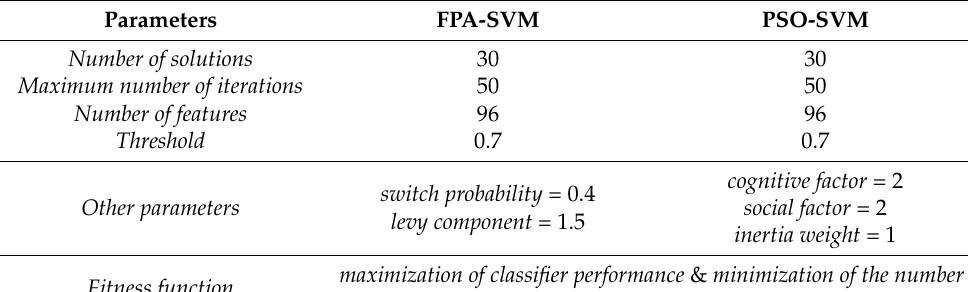
Table 5. Parameter values of wrapper feature selection approaches used in the study. Parameters FPA-SVM PSO-SVM Number of solutions 30 30 Maximum number of iterations 50 50 Number of features 96 96 Threshold 0.7 0.7 cognitive factor = 2 switch probability = 0.4 Other parameters social factor = 2 levy component = 1.5 inertia weight = 1 maximization of classifier performance & minimization of the number Fitness function of selected